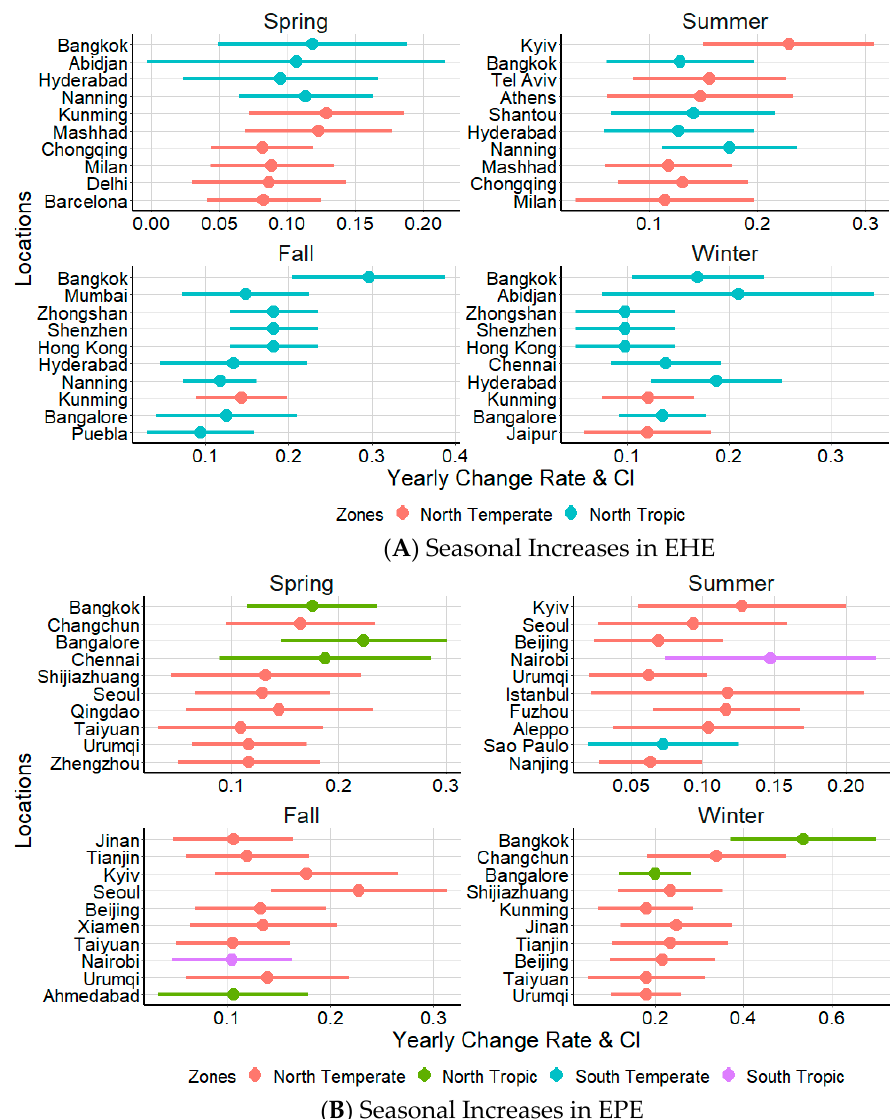
Figure 4. Ten metropolitan locations with the highest rate of seasonal increases in EHE ( top ) and EPE ( bottom ).